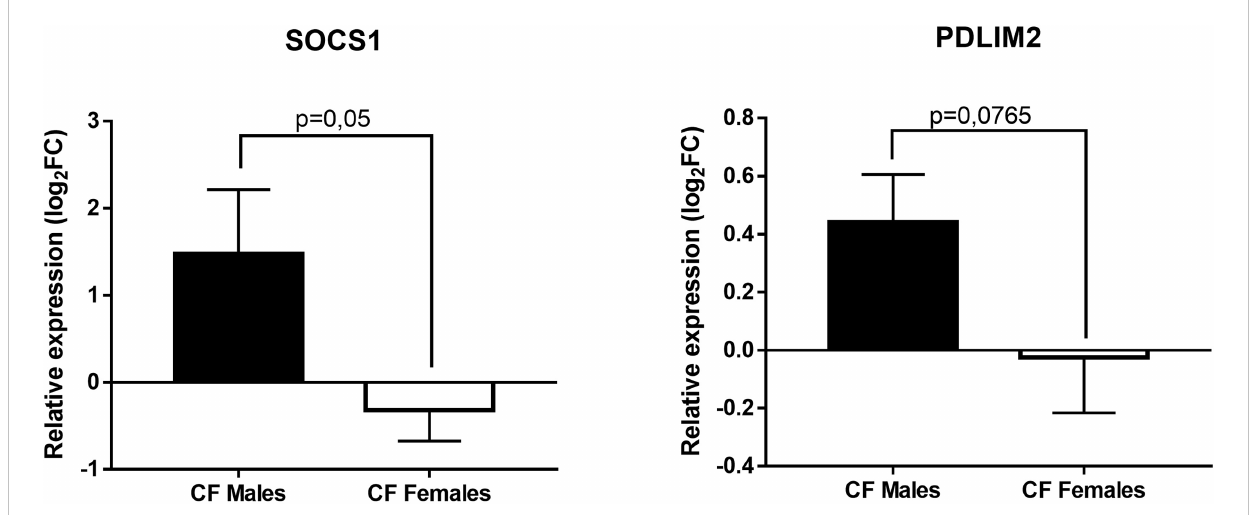
FIGURE 4 Sex-based comparative study of fold change values (log 2 (2 - DD CT )) of SOCS1 and PDLIM2 expression in blood leukocytes between CF males (n=15) and CF females (n=14). The fold change values (2 - DD CT ) are relative to those from sex-matched healthy controls (n=10/group). Graphs show the mean ±